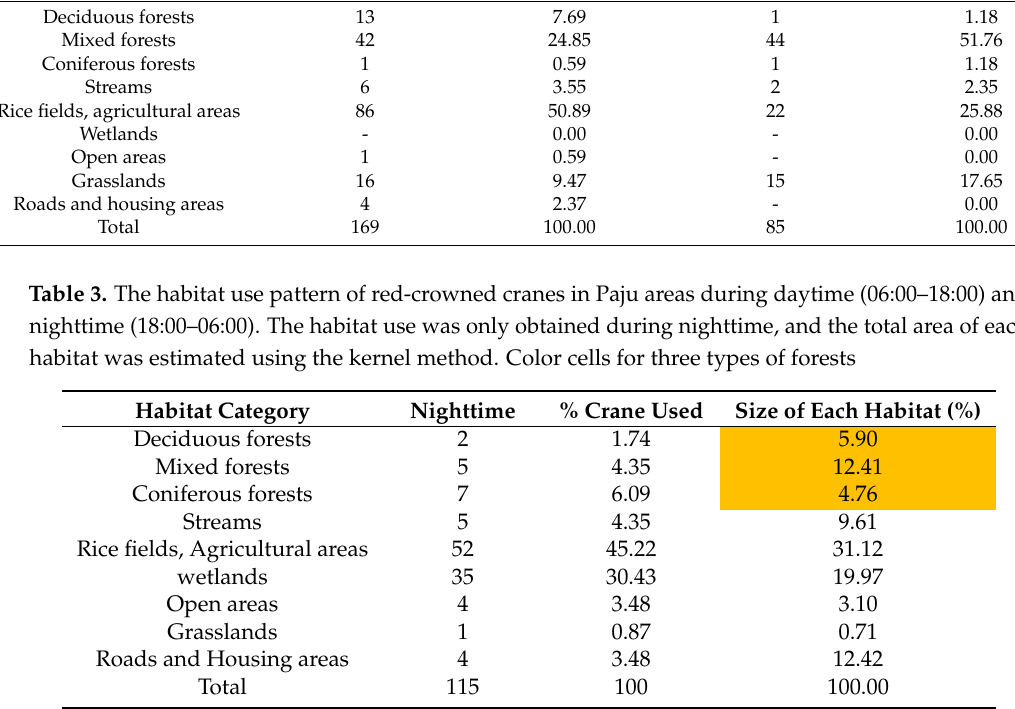
Table 2. The habitat use pattern of red-crowned cranes by % in Cheolwon areas during daytime (06:00–18:00) and nighttime (18:00–06:00). Habitat Category Daytime Data Points % of Each Habitat